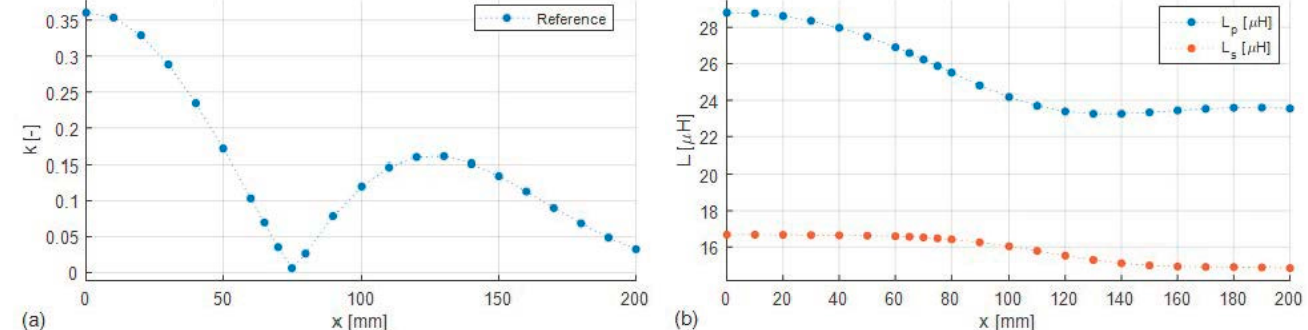
Figure 7. Reference values for x-axis displacement. ( a ) Coupling coefficient k . ( b ) The primary and secondary inductances L 1 and L 2 .